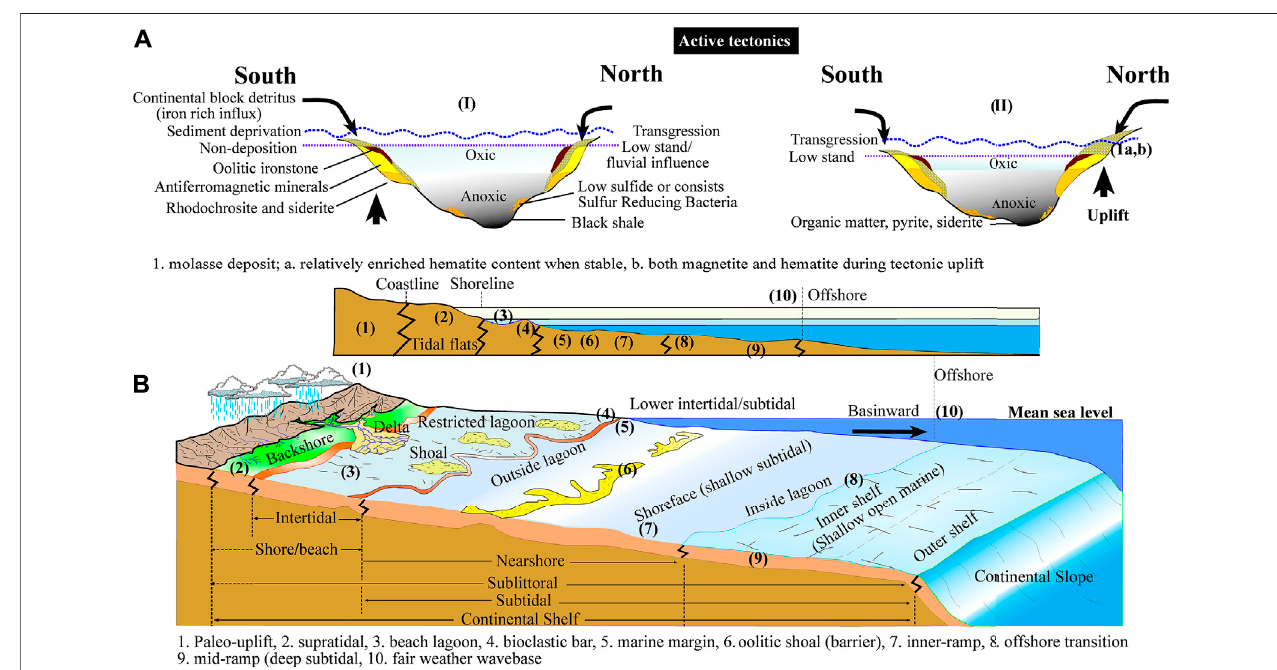
FIGURE9 |(A) The plausible process for varied magnetic mineral compositionin adepocenter in anactive tectonic system: uplift slowlydecreasesin thesouthern part butincreasesrapidlyinthenorthernpart, intheNepalHimalaya. (I)and (II)illustrates thedepositionalsettingofhowcontinentalblockdetritusand magneticminerals accumulate in a basin, in response to the tectonically active and inactive conditions. This type of depositional setting most likely controlled χ variation. (B) Schematic representation of the changes in the potential paleodepositional environments of the Amile and Bhainskati formations in the Lesser Himalaya, Nepal. It shows the probable accumulation of terrestrial and marine deposits (e.g., fi ne sediments or in the form of molasse deposits) during the marine transgression/regression process, with respect to the tectonic uplift during and after the Indian-Eurasian collision, ultimately affecting the magnetic enrichment within the basin.